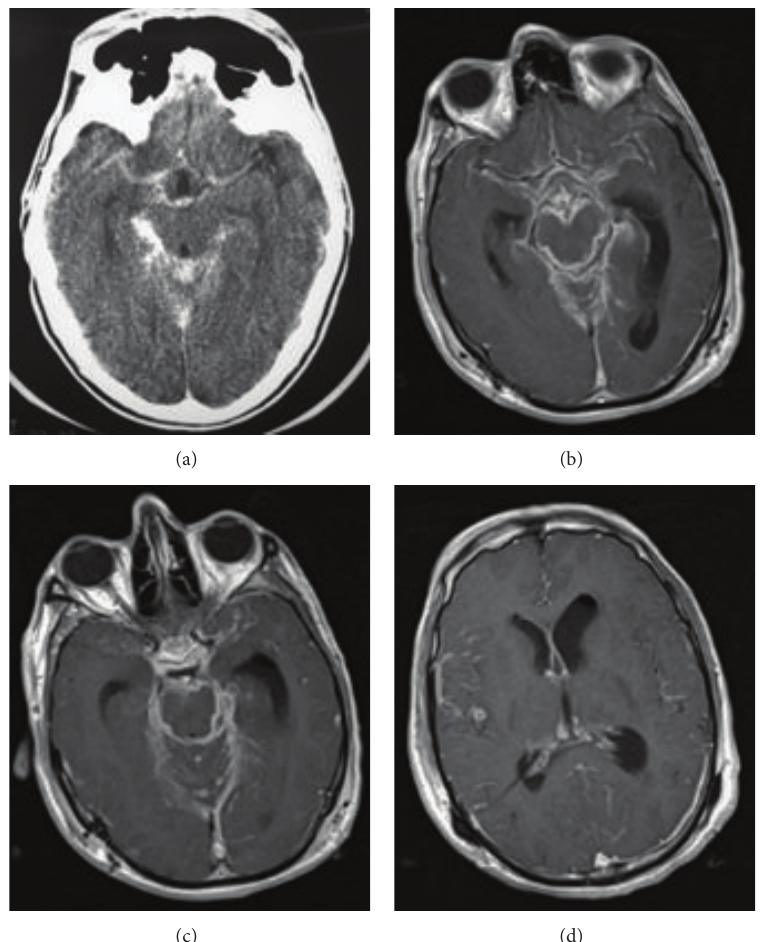
Figure 1: Meningeal tuberculosis. (a) Axial postcontrast brain CT shows typical thick enhancement of basilar cisterns. (b) Axial postcontrast T1-weighted MR images in a different patient ((b), (c), and (d)) demonstrate enhancing basilar exudates and leptomeningeal enhancement. A small tuberculoma in right temporal region (d) and hydrocephaly (more severe in left ventricle) and the evidence of prior craniotomy (Burr hole, left pneumoventricle) are also